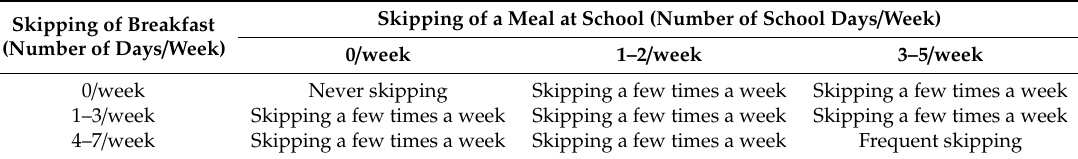
Table 1. Categorizing skipping breakfast and a meal at school considered together. Skipping of Breakfast (Number of Days /